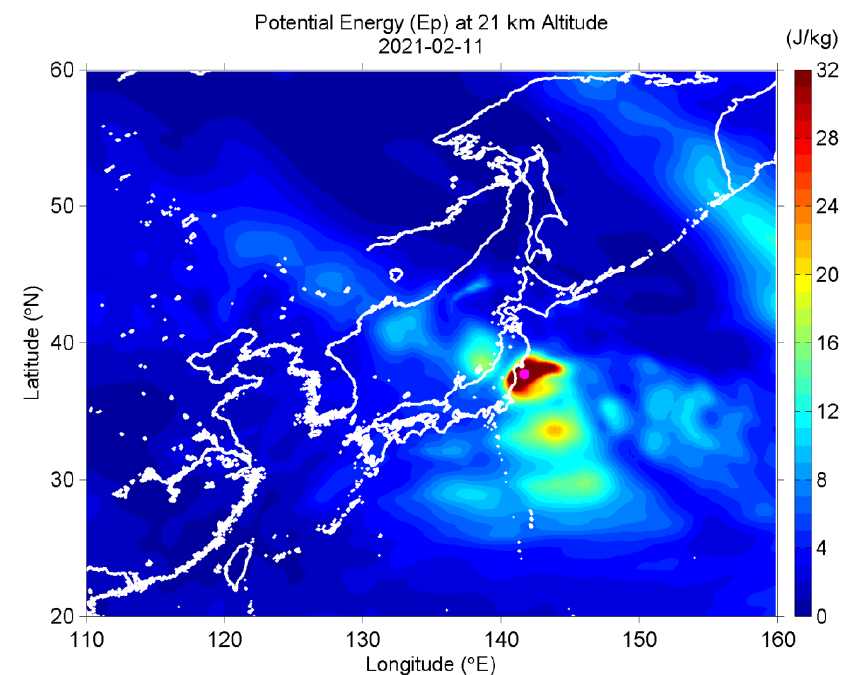
Figure 10. Same as in Figure 9, but on 11 February 2021.